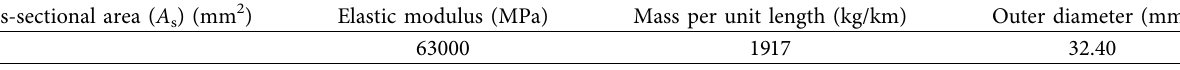
Table 1: Physical parameters of the conductors (JLHA1/G1A-575/40-45/7 ACSR type).